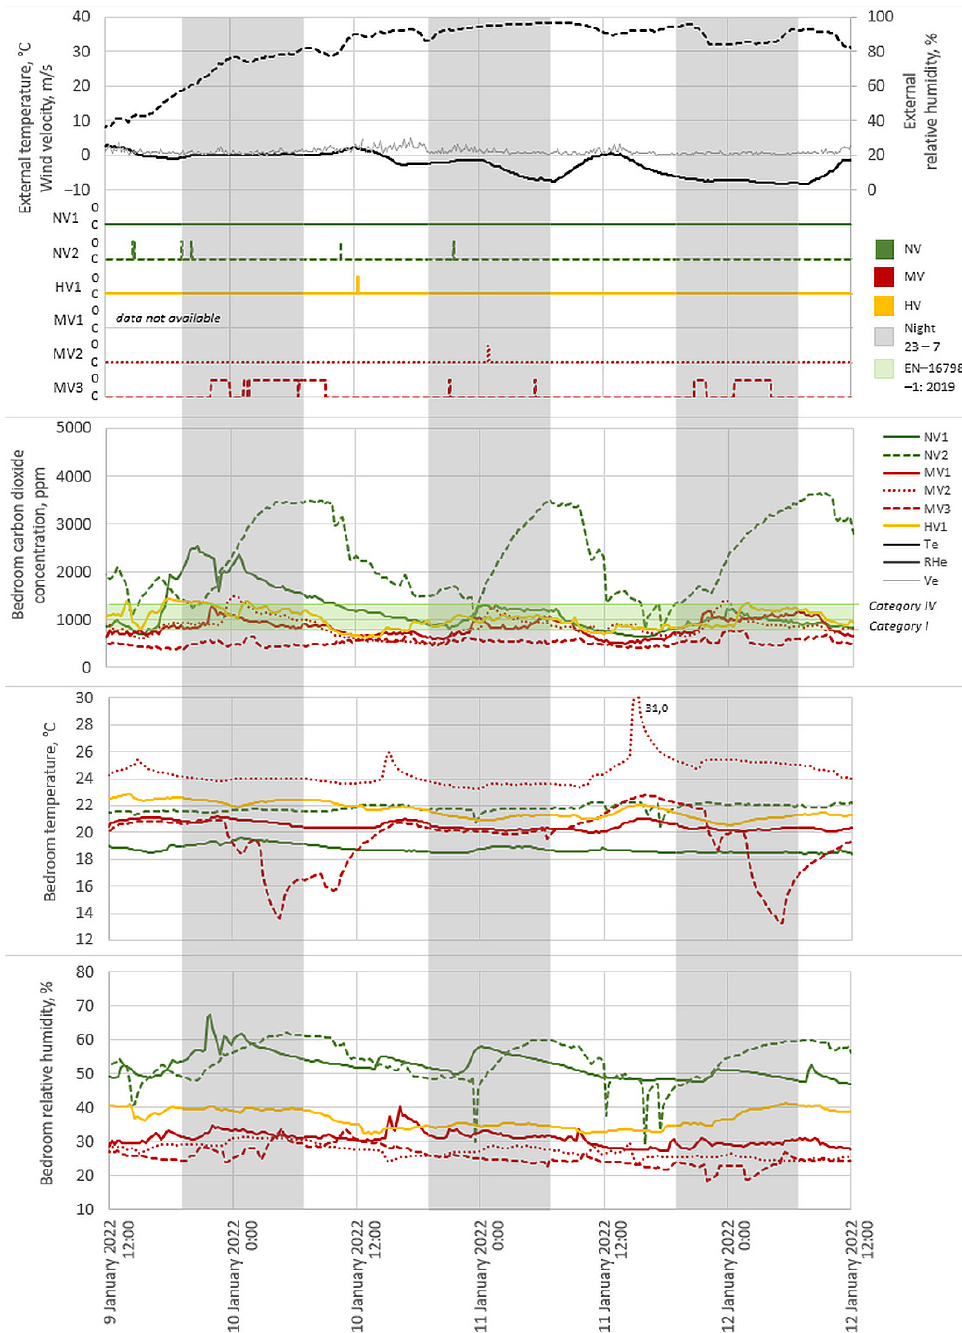
Figure 9. Detailed variability of the measured parameters over the period 09–12 January 2022. For selected periods, the reaction of residents to changing external and internal condi- tions was analyzed. Symbols on the chart “O” and “C” next to the names of objects mean the position of the window “open” and